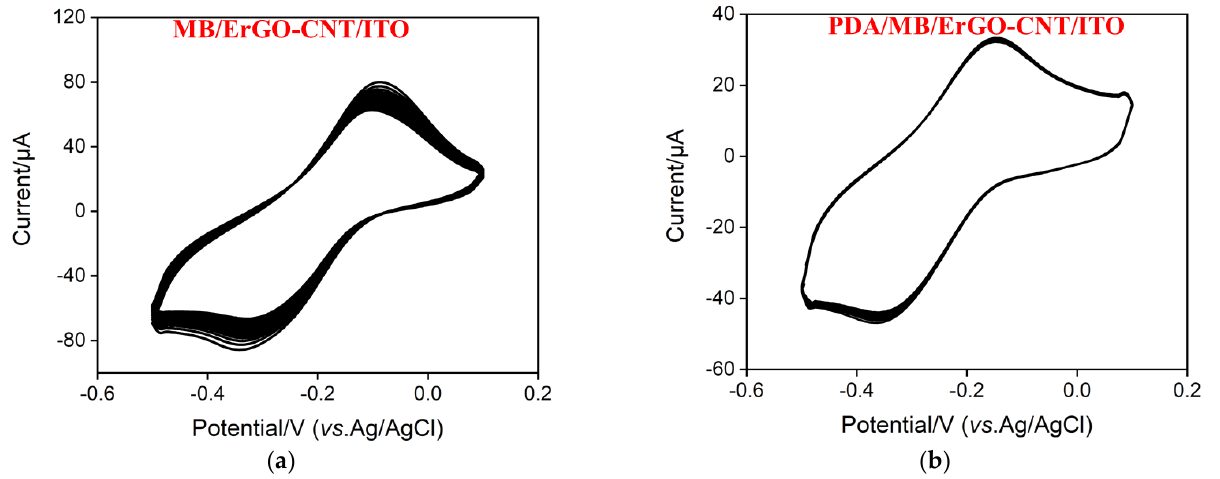
Figure 6. Successive CV curves of the ( a ) MB/ErGO-CNT/ITO and ( b ) PDA/MB/ErGO-CNT/ITO electrodes in 0.01 M PBS (pH = 7.4).